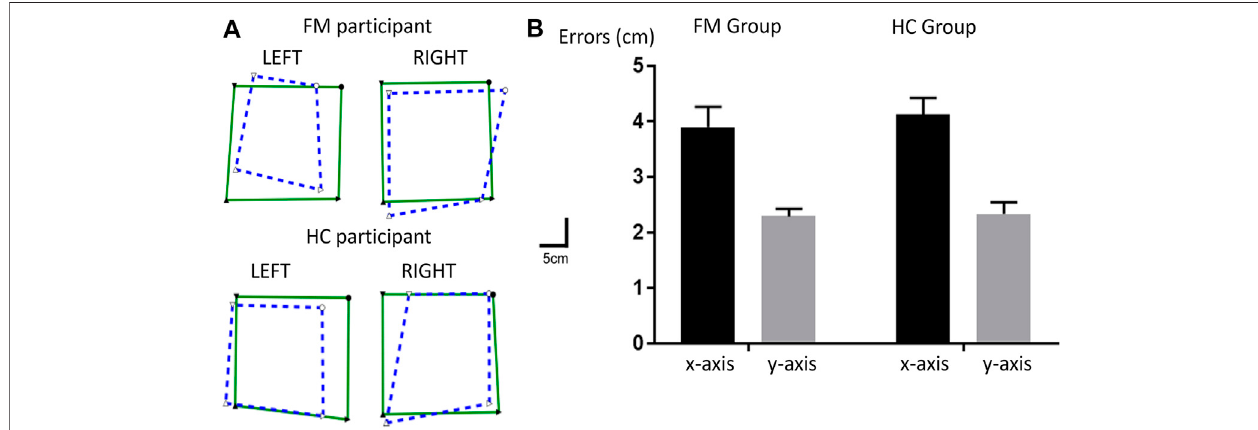
FIGURE7| LimbpositionsenseTask. (A) Individualdataforrepresentativeparticipants fromeachgroup.Thegreensquaresrepresentthepositionofleftandright upper limbs (UL) moved passively by the robot, and the superimposed blue dashed squares represent the matching positions with the contralateral UL. (B) Mean errors for the FM and HC groups in the x- (in black) and y -axes (in gray). Error bars represent the standard error of the